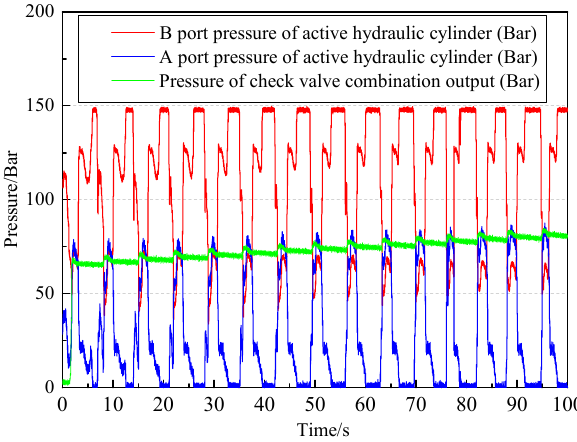
Figure 14. Pressure curves of active hydraulic cylinder and check valve.